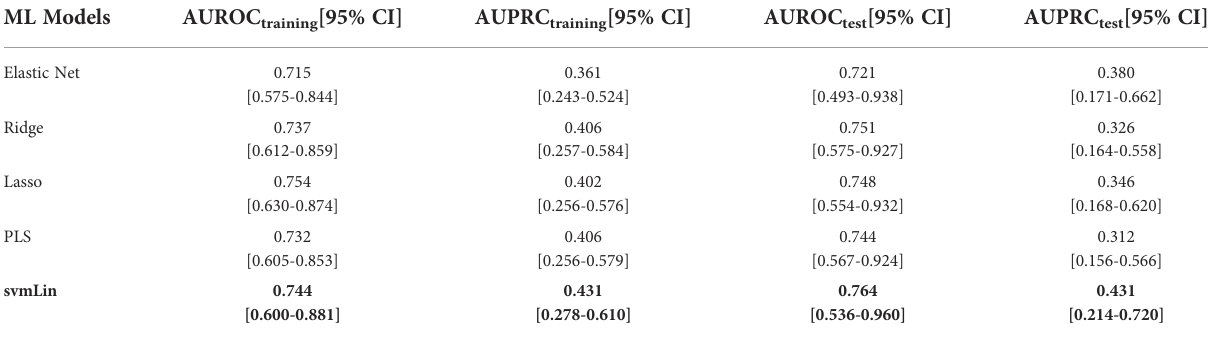
TABLE 3 Summary of the performance of the fi ve different machine learning models on the training and test datasets.